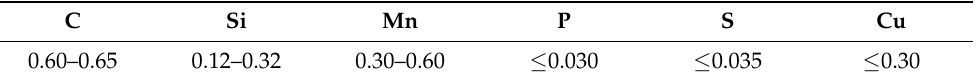
Table 1. Chemical composition of SBPR 930/1080 Type B No. 1 medium carbon steel (in